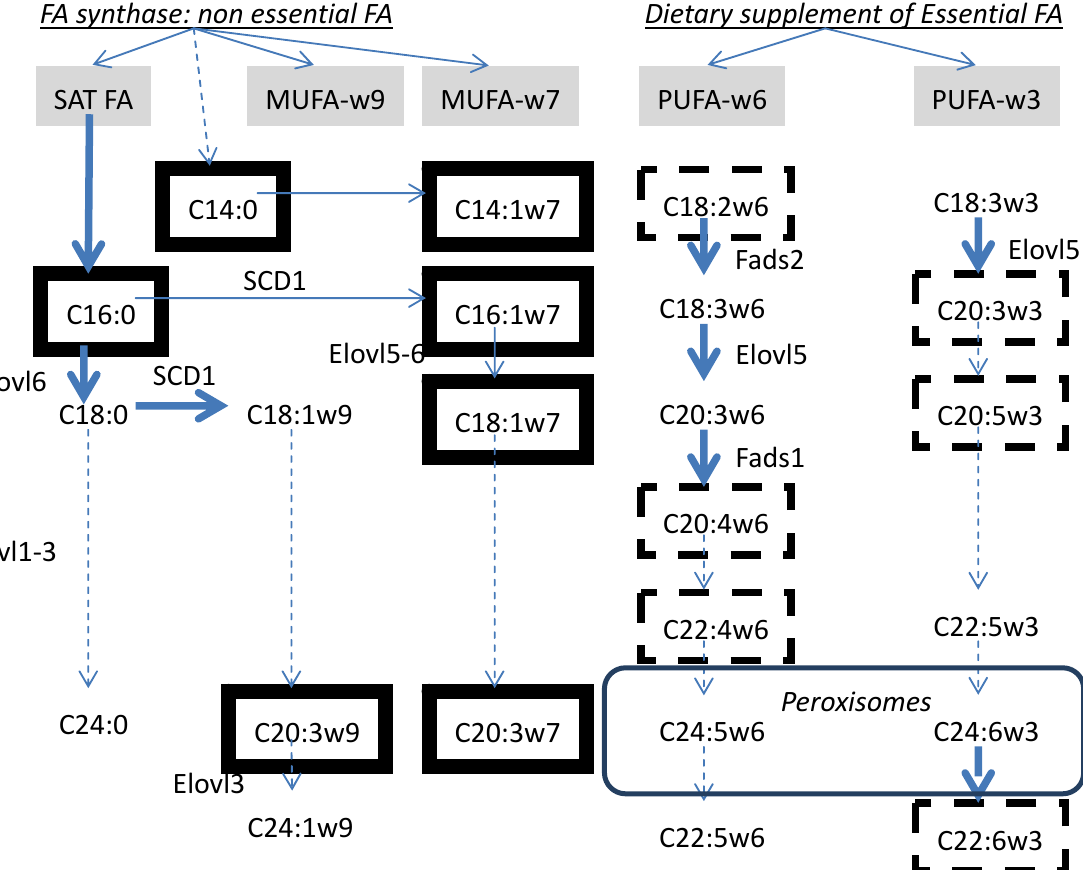
Figure 3. Relationships between endogenous biosynthesis of non-essential fatty acids and dietary sources of essential fatty acids. The separation between pathways leading to the synthesis of non-essential fatty acids (saturated (SAT) and monounsaturated (MUFA- ω 7 and - ω 9 families) and essential polyunsaturated fatty acids (PUFA- ω 6 and - ω 3 families) is shown. The interaction (competition for substrate, gene expression) between the separated pathways is presented in the text. Adapted from reference